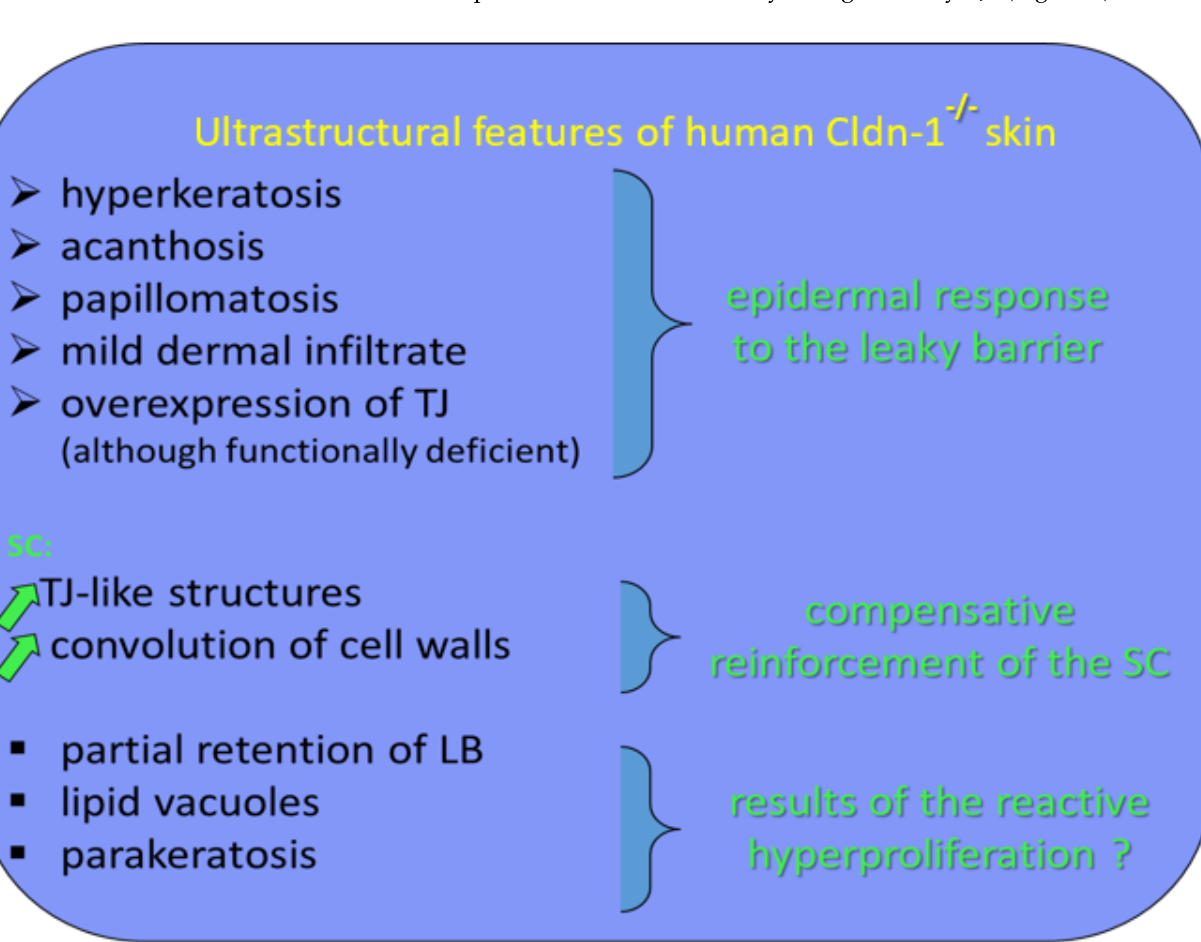
Figure 3. Ultrastructural features of human Cldn-1 − / − skin and their functional translation. Acanthosis is a benign, abnormal thickening of the SS; parakeratosis is a retention of nuclei in the cells of the SC; and papillomatosis consists of papillary projections of the epidermis into the dermis forming a microscopically undulating surface.